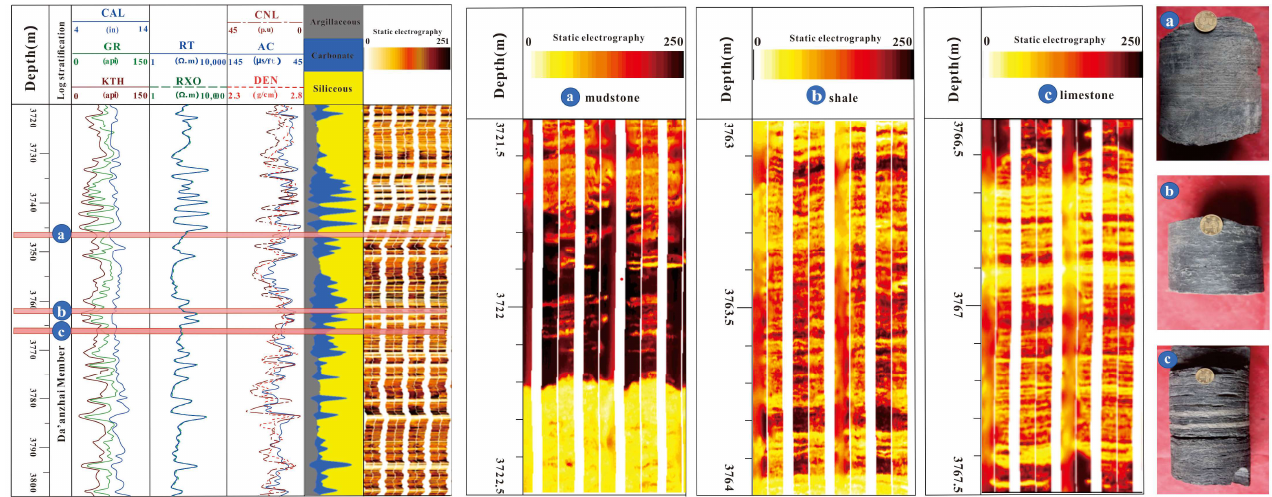
Figure 12. FMI electrical imaging characteristics of Well XA. ( a ) Electrical imaging characteristics of mudstone. ( b ) Electrical imaging characteristics of shale. ( c ) Electrical imaging characteristics of limestone.